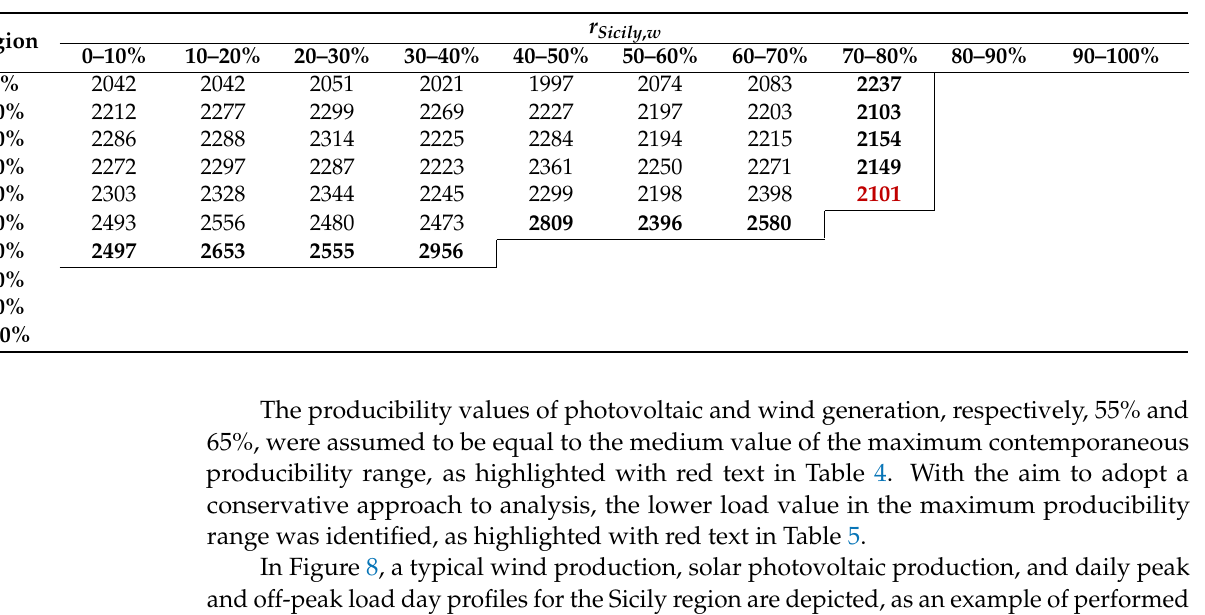
Table 5. Correlation matrix between RES producibilities and load value for Sicily region.